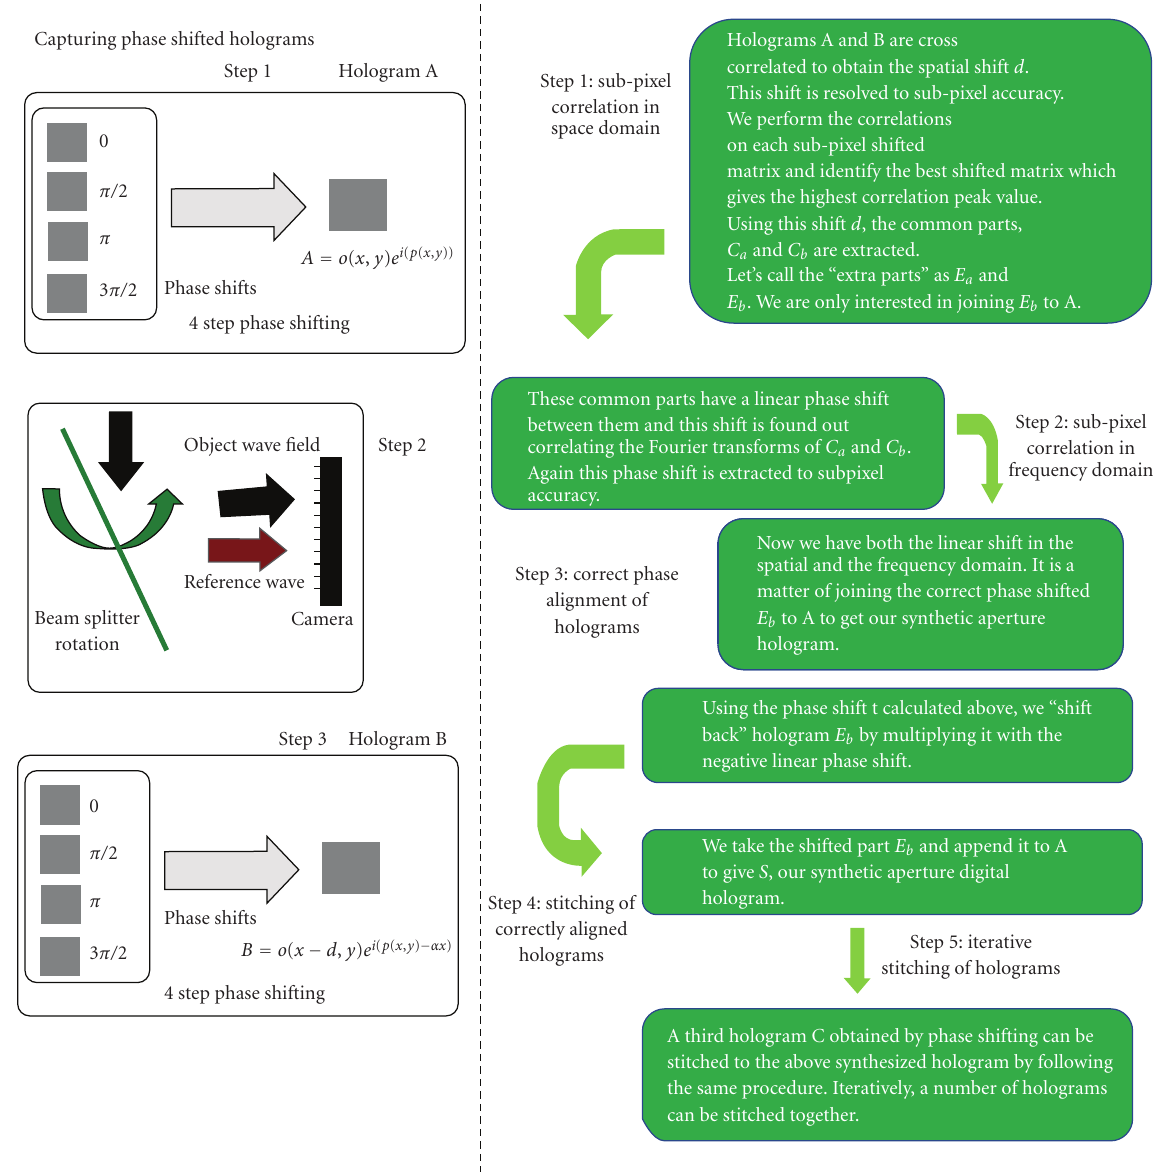
Figure 10: Schematic showing the various steps taken in the stitching process. The beam splitter in Step 2 on the left-hand side corresponds to BS in Figure 1. It is rotated in order to rotate the object wave